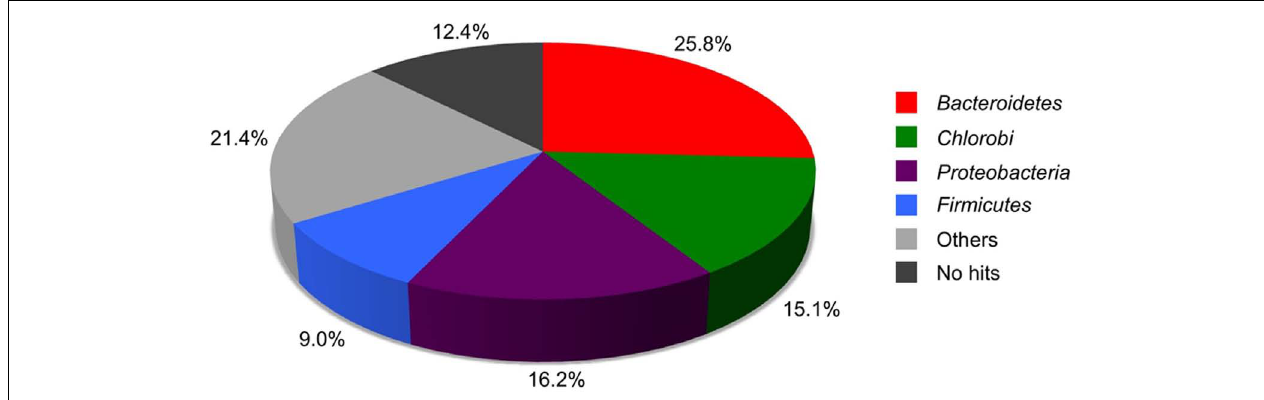
FIGURE 3 | Phylogenetic distribution of BLASTP best hits of I. album proteins compared to proteins in the NCBI nr database. An e -value cut-off of 0.001 was